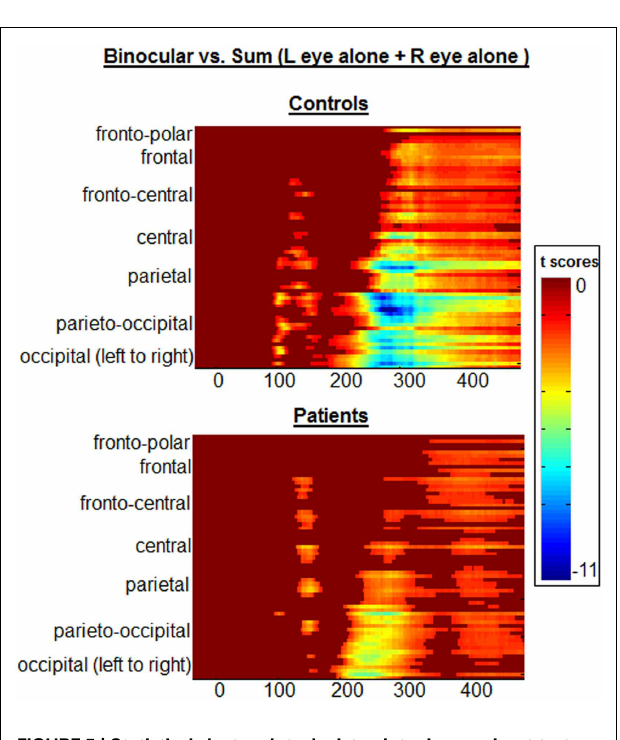
FIGURE 5 | Statistical cluster plots depict point-wise running t -tests comparing the amplitudes of participants’VEPs in Binocular vs. SUM conditions .Time with respect to stimulus onset is presented on the x -axis and the general topographic regions of 72 electrode positions are displayed on the y -axis. Color corresponds to t values. Periods of significant difference are only plotted if a strict alpha criterion of < 0.05 was exceeded for at least 10 consecutive data points.The early “binocular effect” period has been outlined with a black box for each